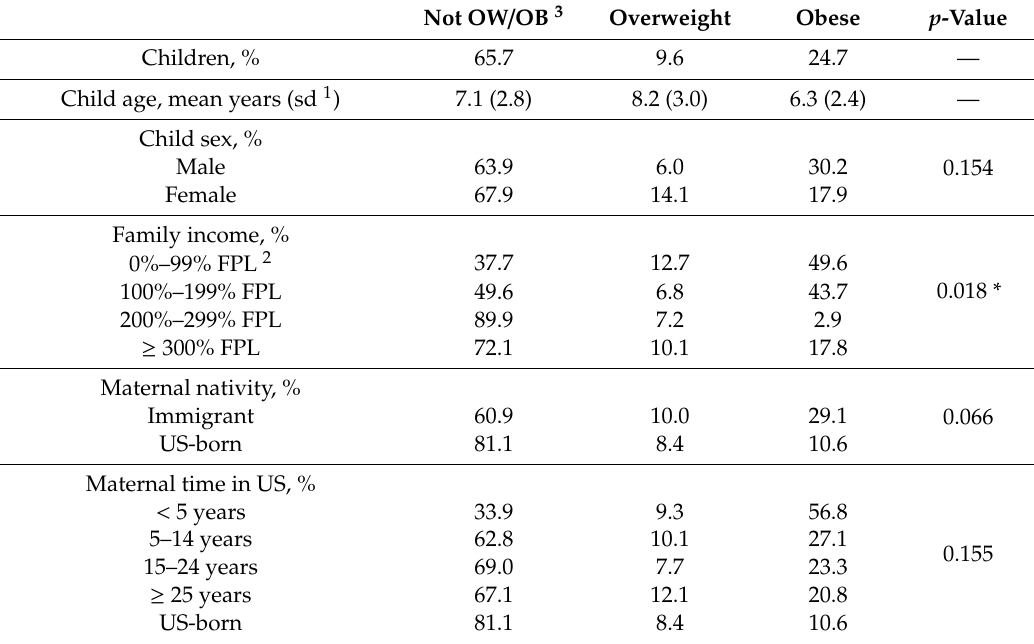
Table 2. Weighted characteristics of Asian American children ages 2 to 11 years old by BMI category (n = 609): CHIS 2013-2016. Not OW / OB 3 Overweight Obese p -Value Children, % 65.7 9.6 24.7 — Child age, mean years (sd 1 ) 7.1 (2.8) 8.2 (3.0) 6.3 (2.4)